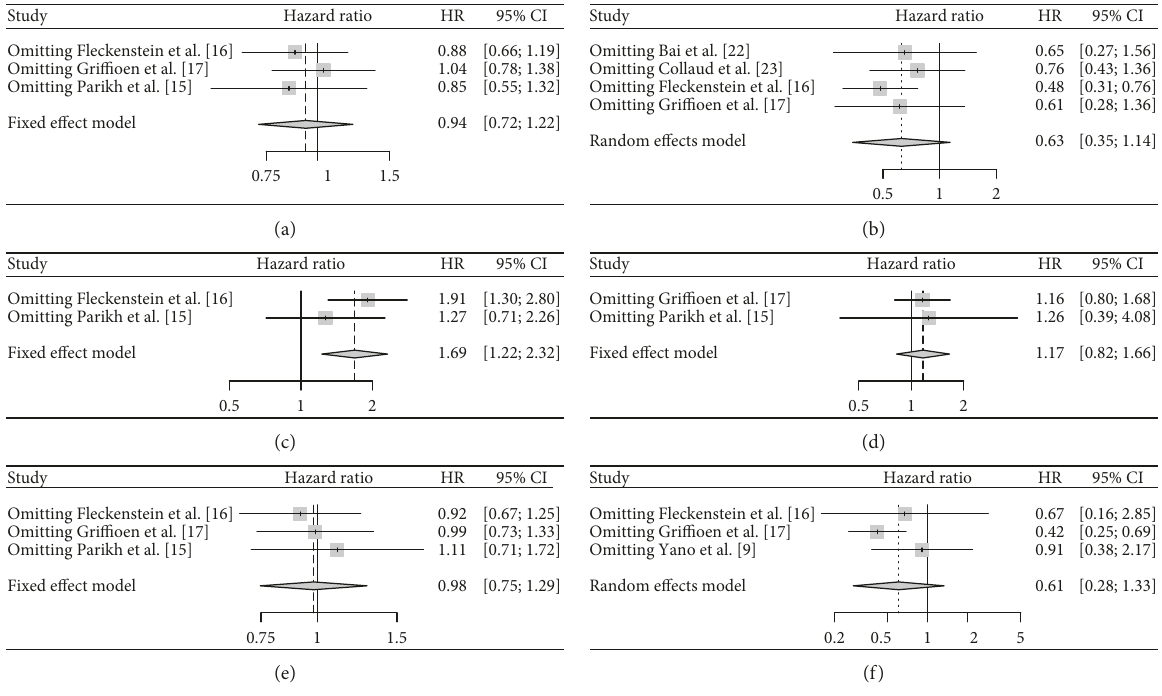
Figure 3: Sensitivity analysis for the association of survival of oligometastatic non-small-cell lung cancer patients with sex (a), stage (b), nodal status (c), smoke (d), age (e), and histology